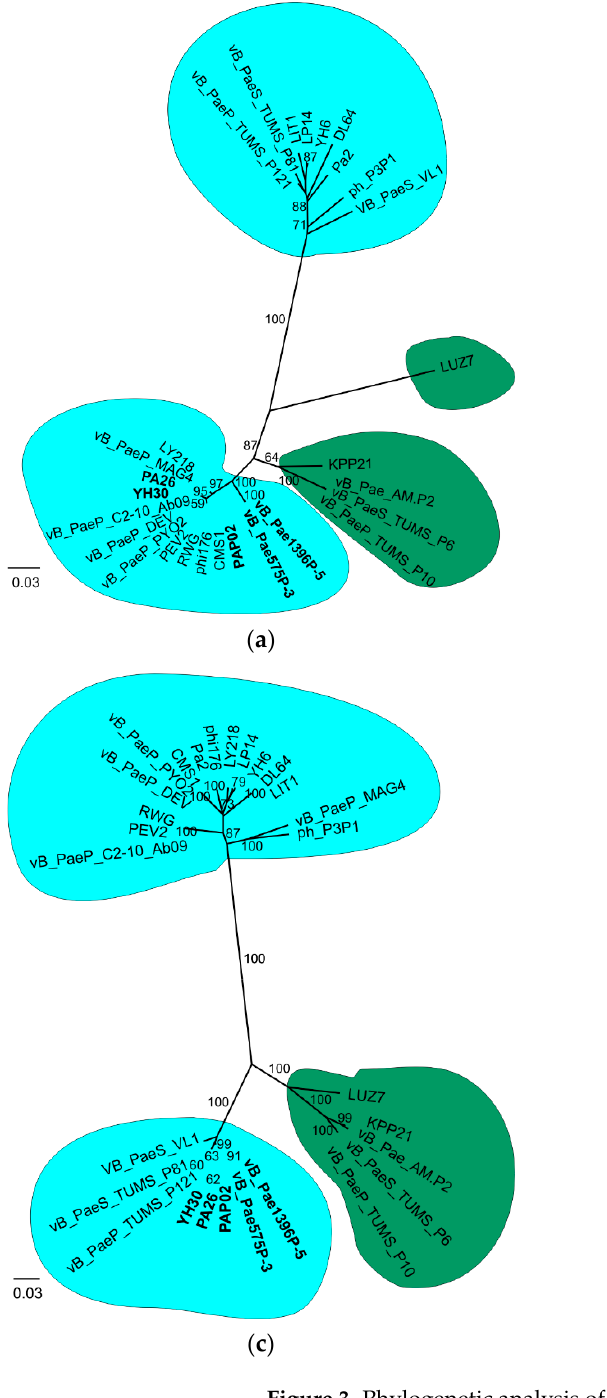
Figure 3. Phylogenetic analysis of particular protein domains within the variable region: ( a ) GrpE- like domain tree; ( b ) GDSL-like lipase/acylhydrolase domain tree; ( c ) pyocin knob domain tree; ( d ) C-terminal end tree. Litunavirus and Luzseptimavirus phages are circled in blue and green, respec- tively. Bootstrap support values are presented on branches and the phylogenetic distance scale is shown as a bar for particular graphs in its proximity. The most crucial viral taxa are presented in bold.